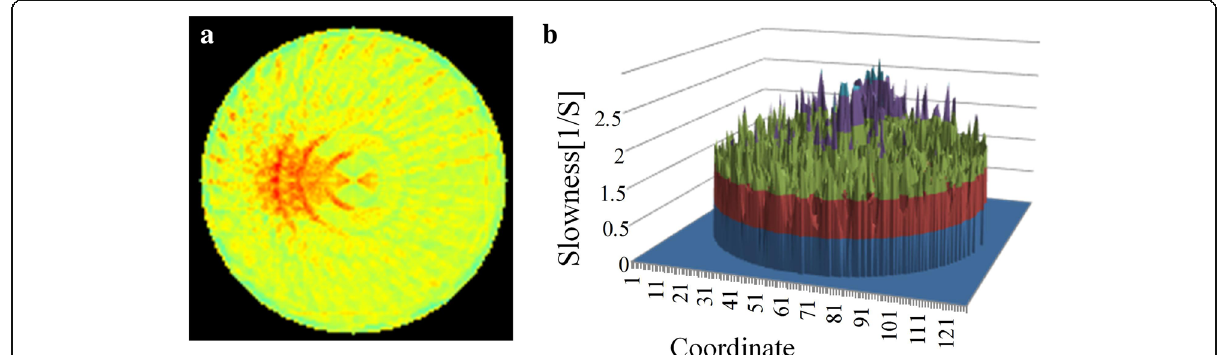
Fig. 4 Three hundred six data reconstruction image and slowness: a reconstruction image with 306 data, b slowness of reconstruction image with 306 data